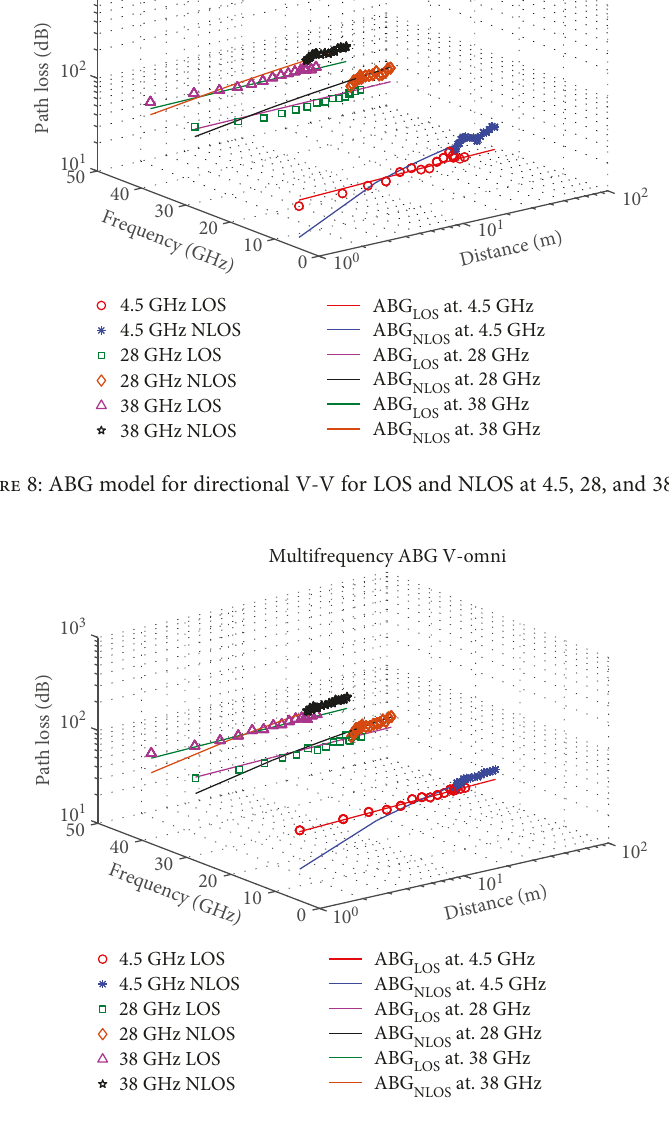
Figure 9: ABG model for omnidirectional V-Omni for LOS and NLOS at 4.5, 28, and 38GHz. Table 4: ABG model parameters for LOS and NLOS at 4.5, 28, and 38GHz. 4.5, 28, and 38 GHz directional ABG model parameters